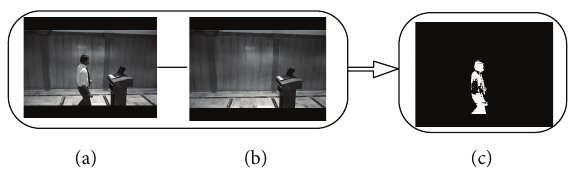
Figure 3: (a) Current image; (b) fixed background image; (c) subtracted image